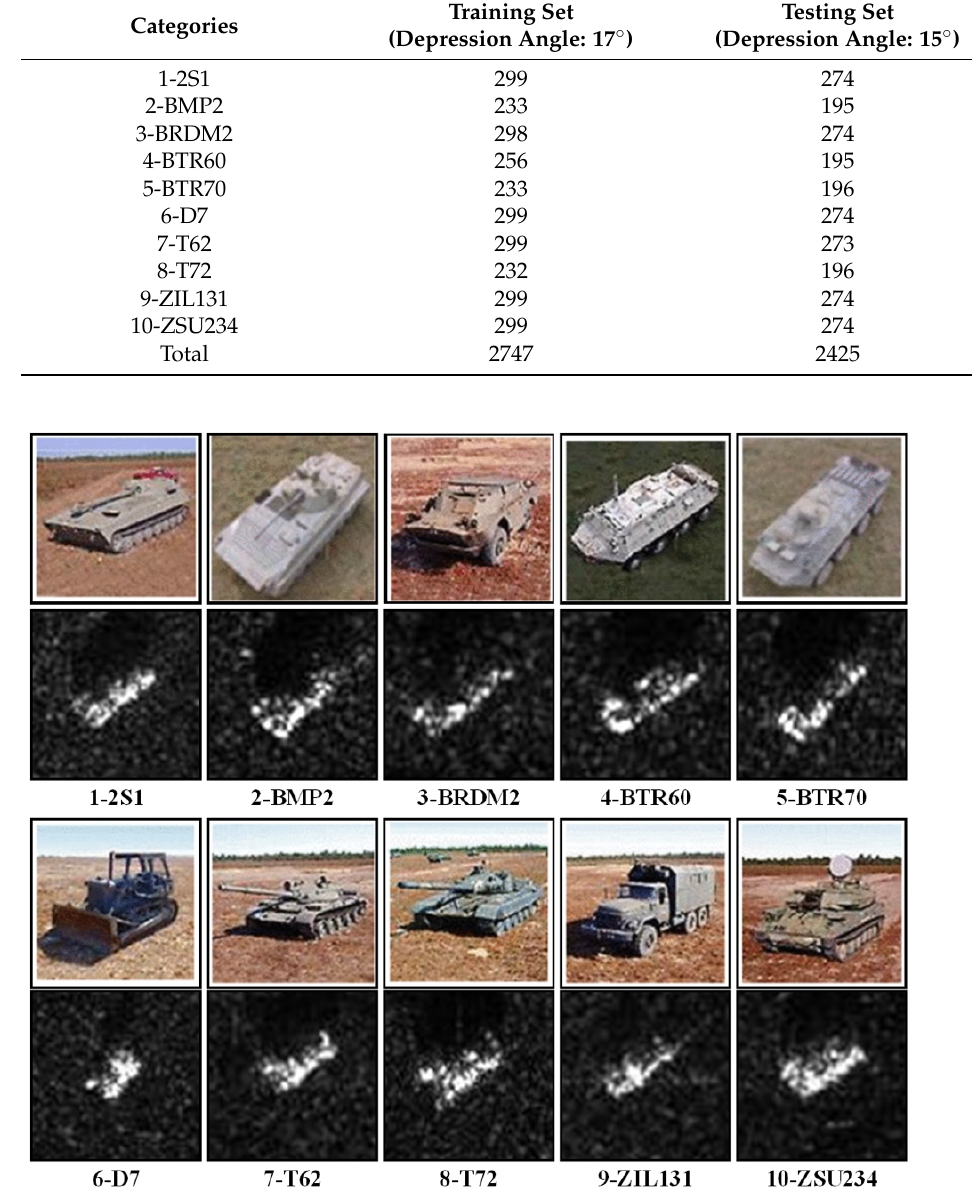
Figure 5. The Optical-SAR image comparison of 10 types of dataset. The experimental hardware configuration is Intel Core i7-7700 CPU, Nvidia 1080Ti GPU; System and software environment: Win10 (Windows System 10, Microsoft, Redmond, WA, USA), Python 3.7 (Python Software Foundation, Wilmington, DE, USA), CUDA 10.1 (Nvidia-USA, Santa Clara, CA, USA), PyTorch 1.6. The experimental results and analysis mainly include FEN performance test and Fea-DA (Facebook-USA, Menlo Park, CA, USA) unknown SAR target identification performance test. The dataset allocation used in the experiment is listed in Table